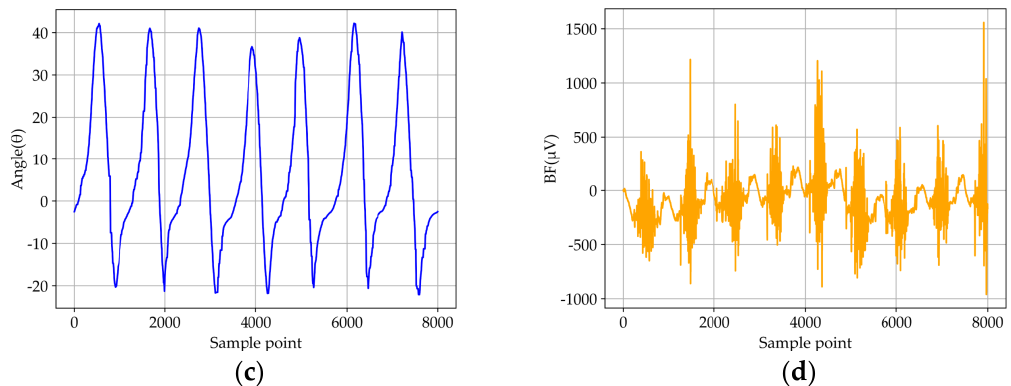
Figure 4. Parts of the test data obtained from the first and second groups of running mode tests. ( a ) Angle signal by IMU in the first group test; ( b ) EMG signal of BF in the first group test; ( c ) angle signal by IMU in the second group test; ( d ) EMG signal of BF in the second group test.